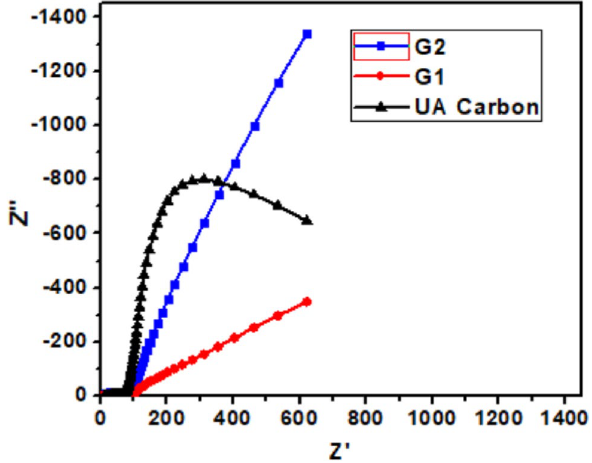
Fig. 7 Impedance curve of EDLC devices based on UA carbon, G1 and G2 derived porous carbon